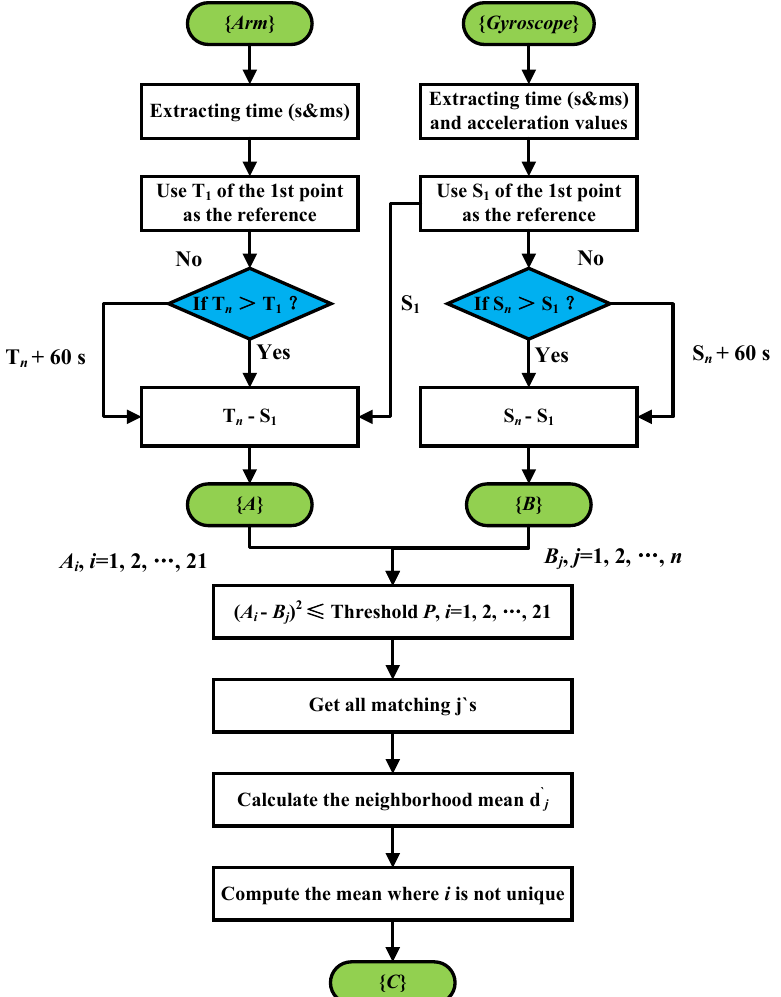
Figure 6. Flow block diagram of the processing based on absolute time